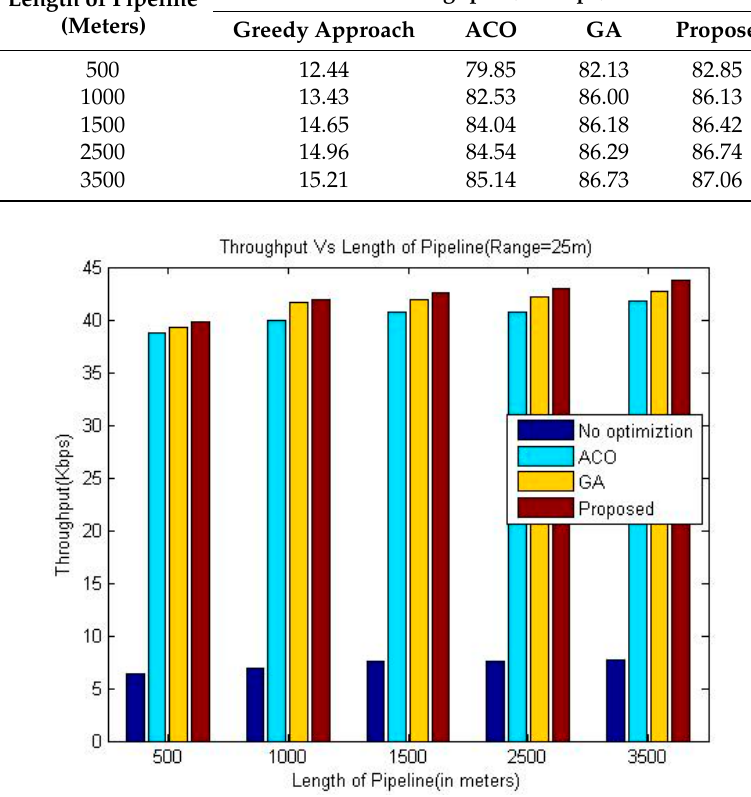
Figure 6. Comparison of Throughput (Range 25 m).